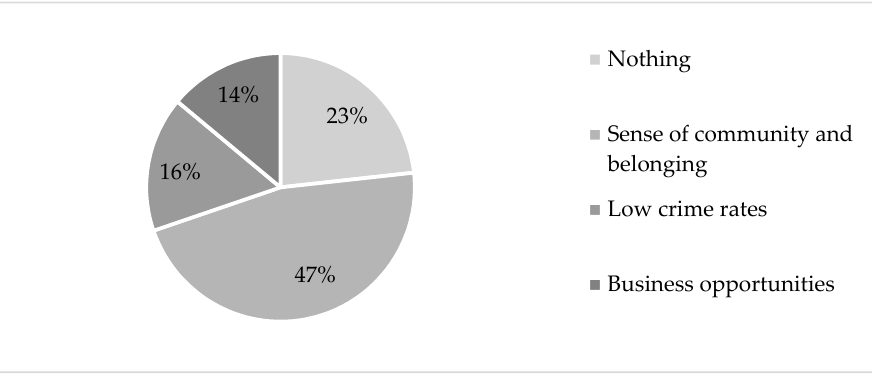
Figure 1. What community members appreciate about RLM.